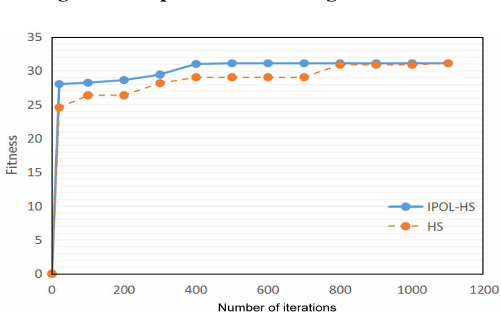
Fig. 10 Comparison of convergence on